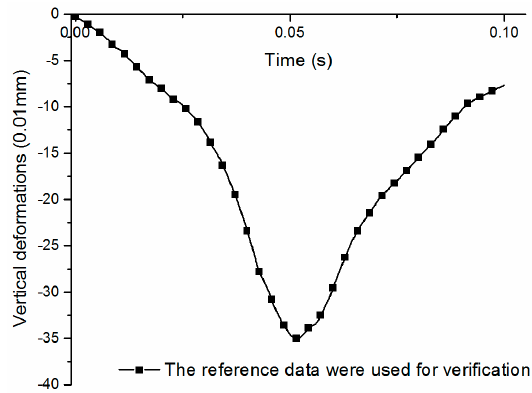
Figure 5. Curves obtained by literature data.